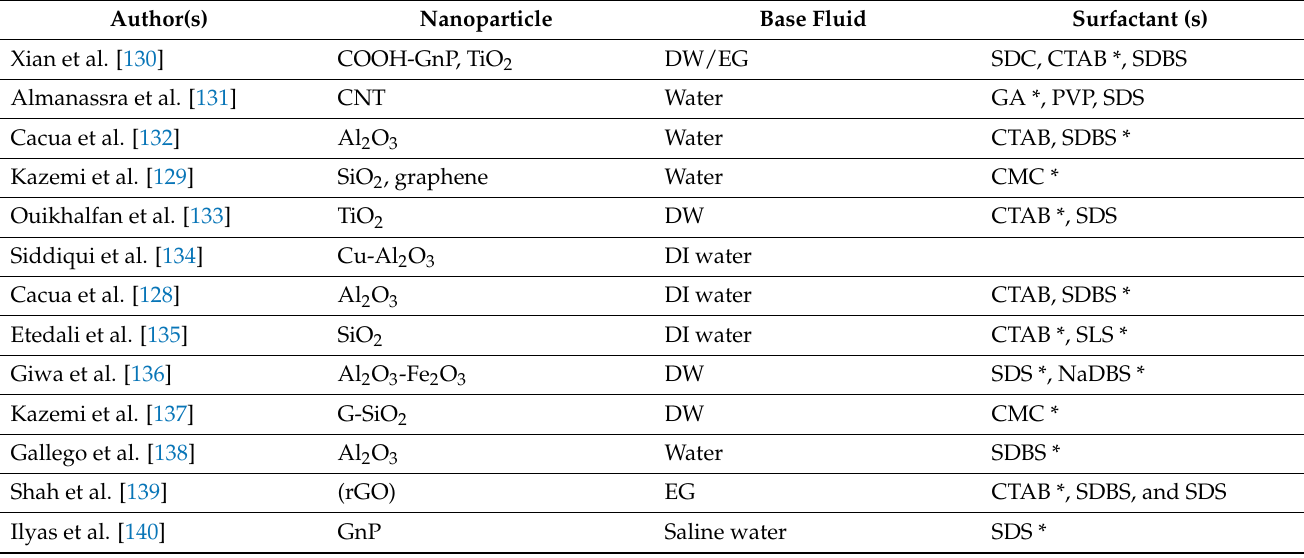
Table 2. Stability of different nanofluids with